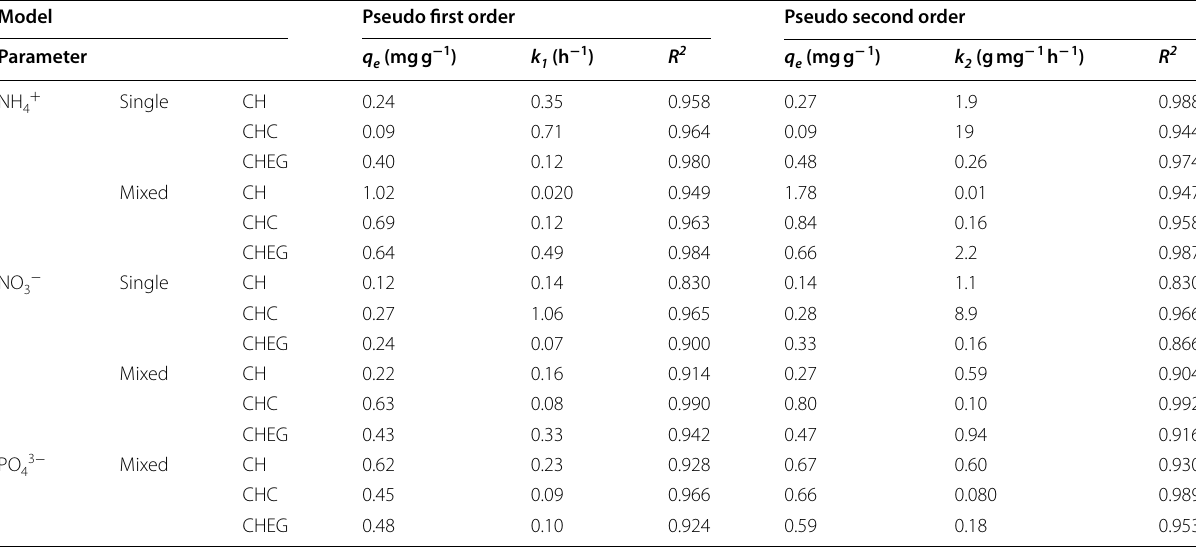
Table 2 Parameters of pseudo first and second order kinetic models for nutrients adsorption from single and mixed solute solution